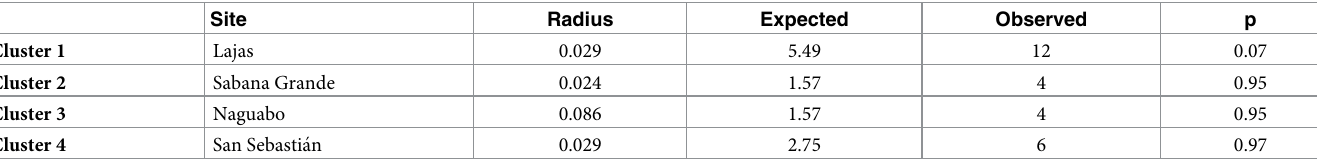
Table 4. Spatial clustering of samples positive for Leptospira at four locations, analyzed in SaTScan using a Bernoulli model. Analyses included Herpestes auropunc- tatus , Rattus spp. and Mus musculus collected from cattle farms in Puerto Rico. All positive samples throughout sampling sites were analyzed to determine if more positive samples that expected were detected in any given area using ci-square